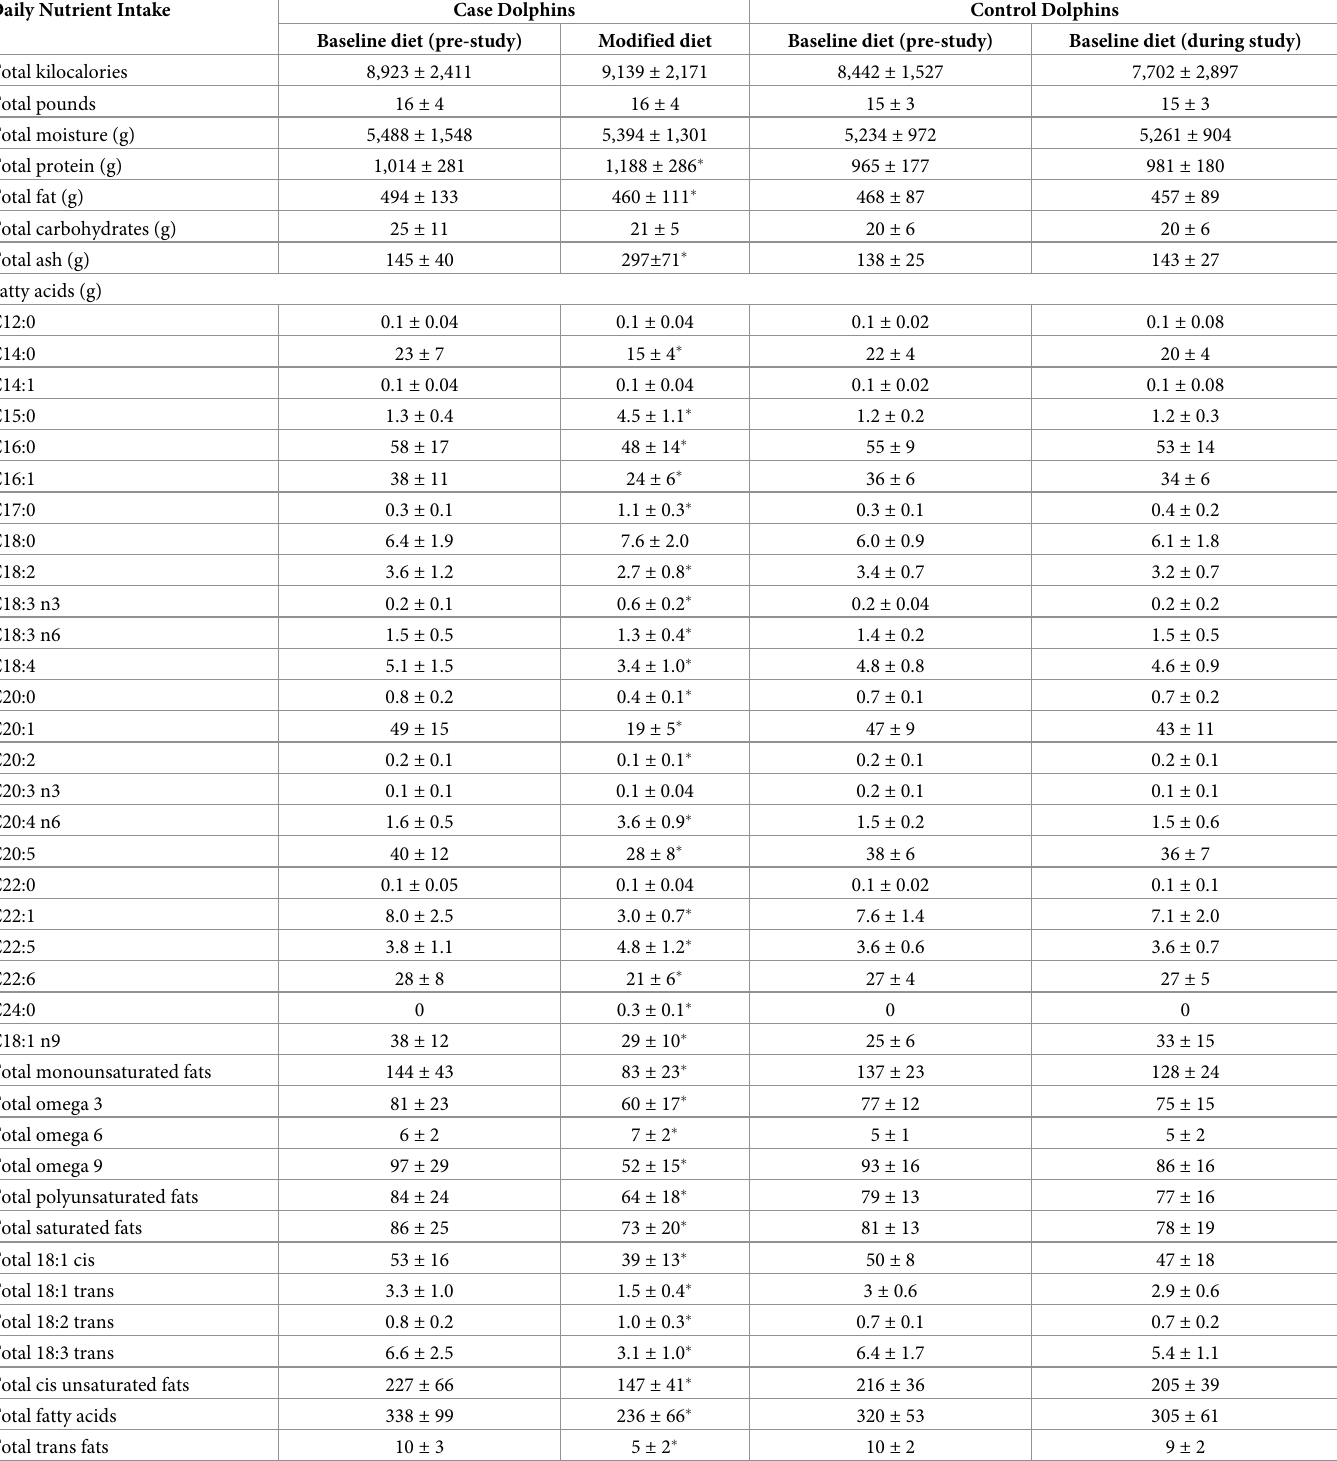
Table 5. Comparisons of average daily nutrient and fatty acid intake in bottlenose dolphins ( Tursiops truncatus ) fed a modified versus baseline diet over 6 months. Daily Nutrient Intake Case Dolphins Control Dolphins Baseline diet (pre-study) Modified diet Baseline diet